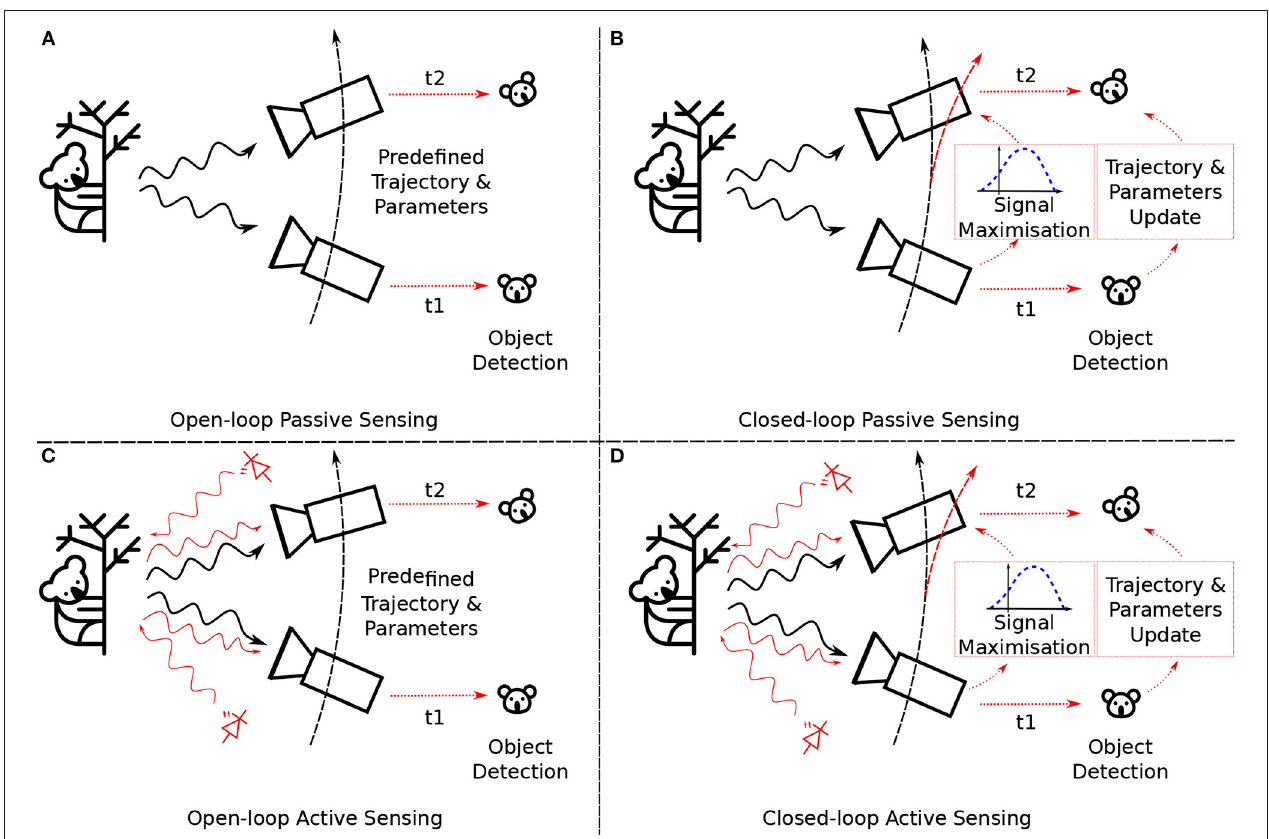
FIGURE 1 | Different modes of sensing. Sensing and consequently processing of sensory information can be divided into passive (top, A and B) vs. active (bottom, C and D) , as well as open- (left, A and C) vs. closed-loop (right, B and D) sensing. Open-loop passive sensing (A) is the most prevalent form of acquiring information about the environment and subsequently using this information, e.g., to classify objects. Advantages of this approach include the one-to-one mapping of inputs and outputs and the readily available optimisation schemes that obtain such a mapping. Examples for open-loop passive sensing include surveillance applications, face recognition, object localisation, and most conventional computer vision applications. While the environment and/or the sensor could move, the trajectory itself is independent of the acquired information. Open-loop active sensing (C) is characterised by injecting energy into the environment. The acquired data is a combination of information emitted by the environment itself (black arrow) and the resulting interaction of the signal emitted by the sensor with the environment (red arrow). Prime examples of this sensing approach are LiDAR, RADAR, or SONAR. In the open-loop setting, the acquired information is not used to change parameters of the sensor itself. The closed-loop passive sensing strategy (B) is most commonly found in animals, including humans. While energy is solely emitted by the environment, the acquired information is used to actively change the relative position of the sensor (e.g., saccadic eye movements) or alter the sensory parameters (e.g., focus). This closed-loop approach utilises past information to make informed decisions in the future. The last sensing category is active closed-loop sensing (D) where the acquired information is used to alter the positioning and configuration of the sensor. Bats (Griffin, 1958; Fenton, 1984) and weakly electric fish (Flock and Wersäll, 1962; Hofmann et al., 2013) are prime examples from the animal kingdom that exploit this sensing style, but also artificial systems, such as adaptive LiDAR, use acquired information about the environment to perform more focused and dense information collection from subsequent